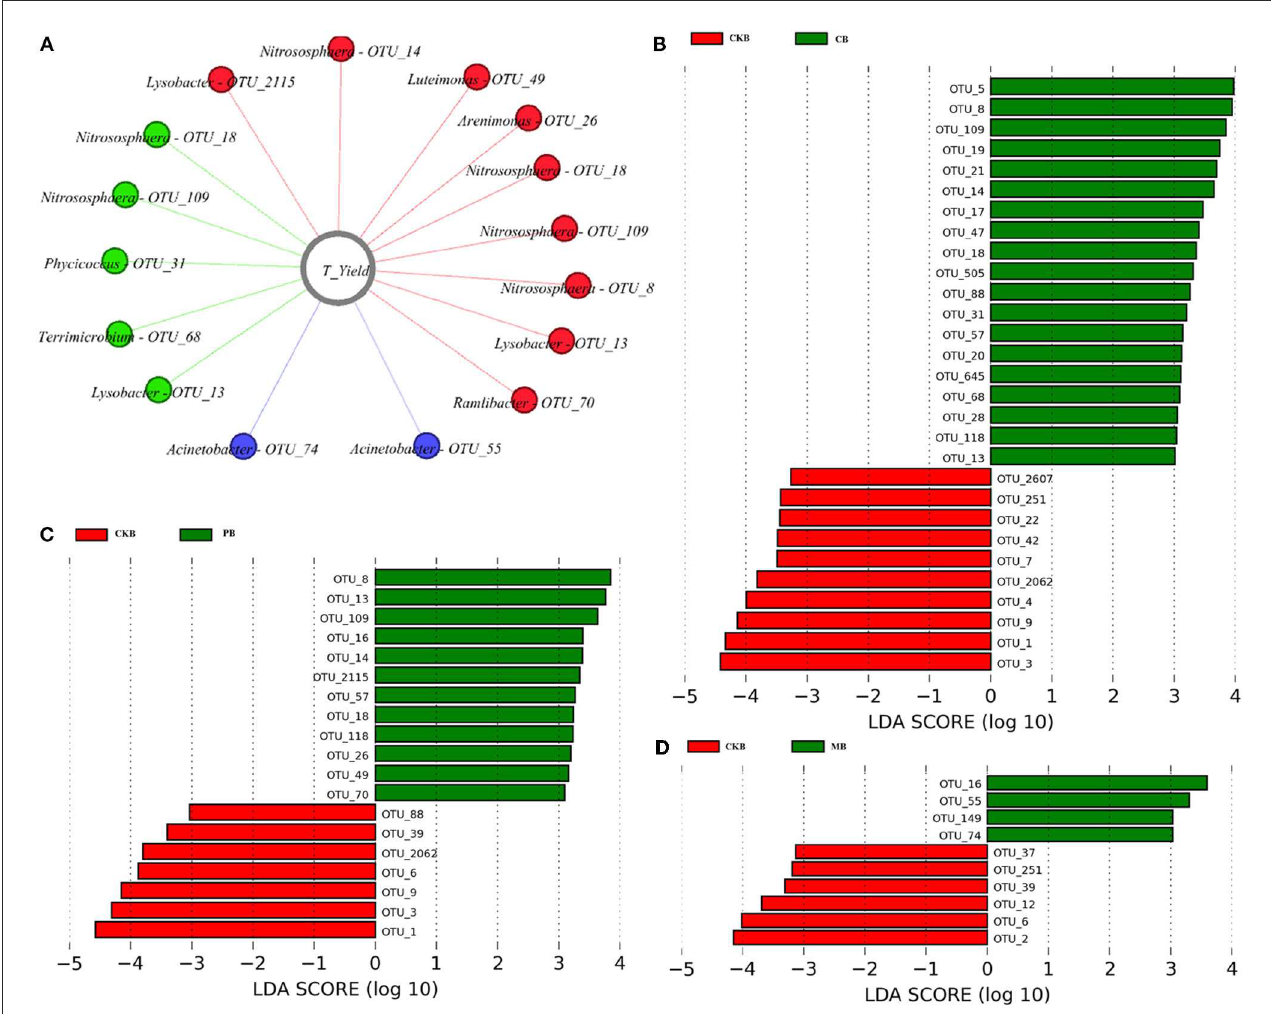
FIGURE4 LefSe analysis between three treatment groups and the control group. (A) The enriched significantly OTU in the PB, CB, MB group were significantly positively correlated with the total yield of pepper ( R > 0.5, P < 0.05), respectively. (B) The significantly enriched OTU between CB and CK group. (C) The significantly enriched OTU between PB and CK group. (D) The significantly enriched OTU between MB and CK